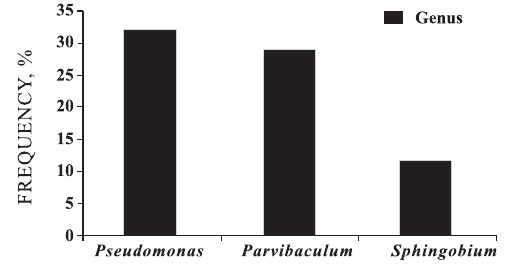
Figure 3. Frequency of clones from the most represented genus in the 16S rDNA library from the